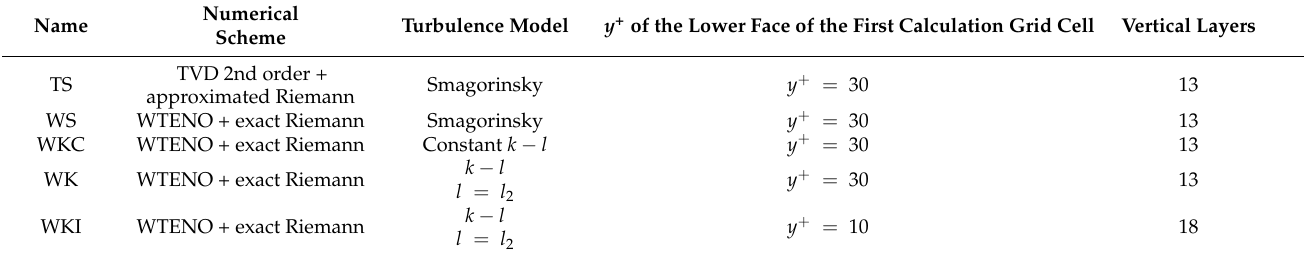
Figure 4. Discretization of the vertical cells outside the buffer layer ( a ) and inside the buffer layer ( b ) for the 𝑘 − 𝑙 model.